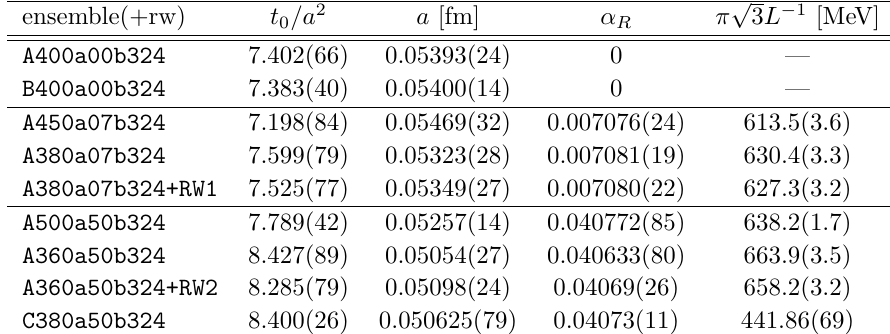
Table 4 . For each ensemble (possibly with mass reweighting): reference observable t 0 /a 2 , lattice spacing a calculated from the measured value of t 0 /a 2 , the renormalized fine-structure constant α R , √ the tree-level energy gap of the photon π 3 L − 1 . Values in physical units are obtained by using the reference value (8 t 0 ) 1 / 2 = 0 . 415 fm